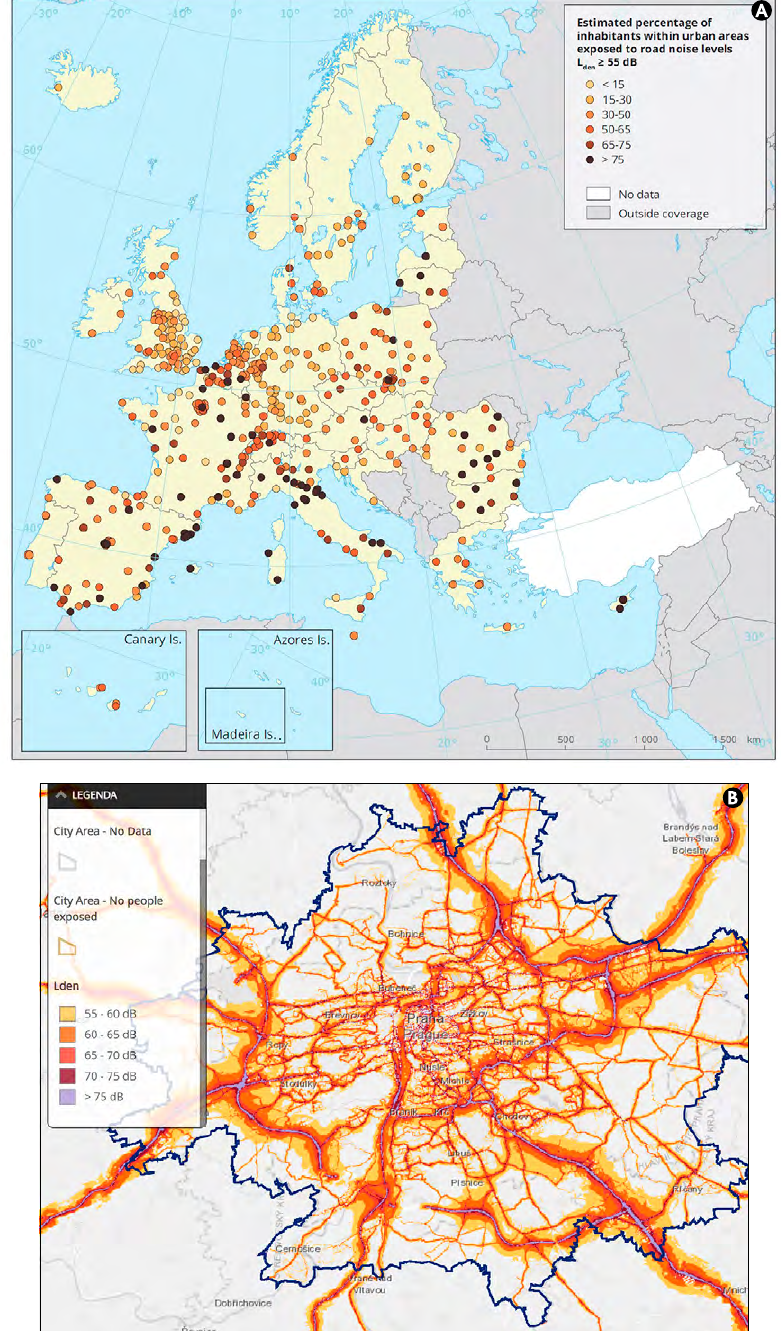
Figure 5. A) Estimated percentage of population in cities from EU and EEA (+ CH) countries that are exposed to road traffic noise levels L ≥ 55 dB in 2017; B) Urban area of Prague that is exposed to day-evening-nighttime average sound den levels of L ≥ 55 dB from road traffic noise. In this exposed area of Prague lives about 876 000 inhabitants den Sources: EEA, 2020 and